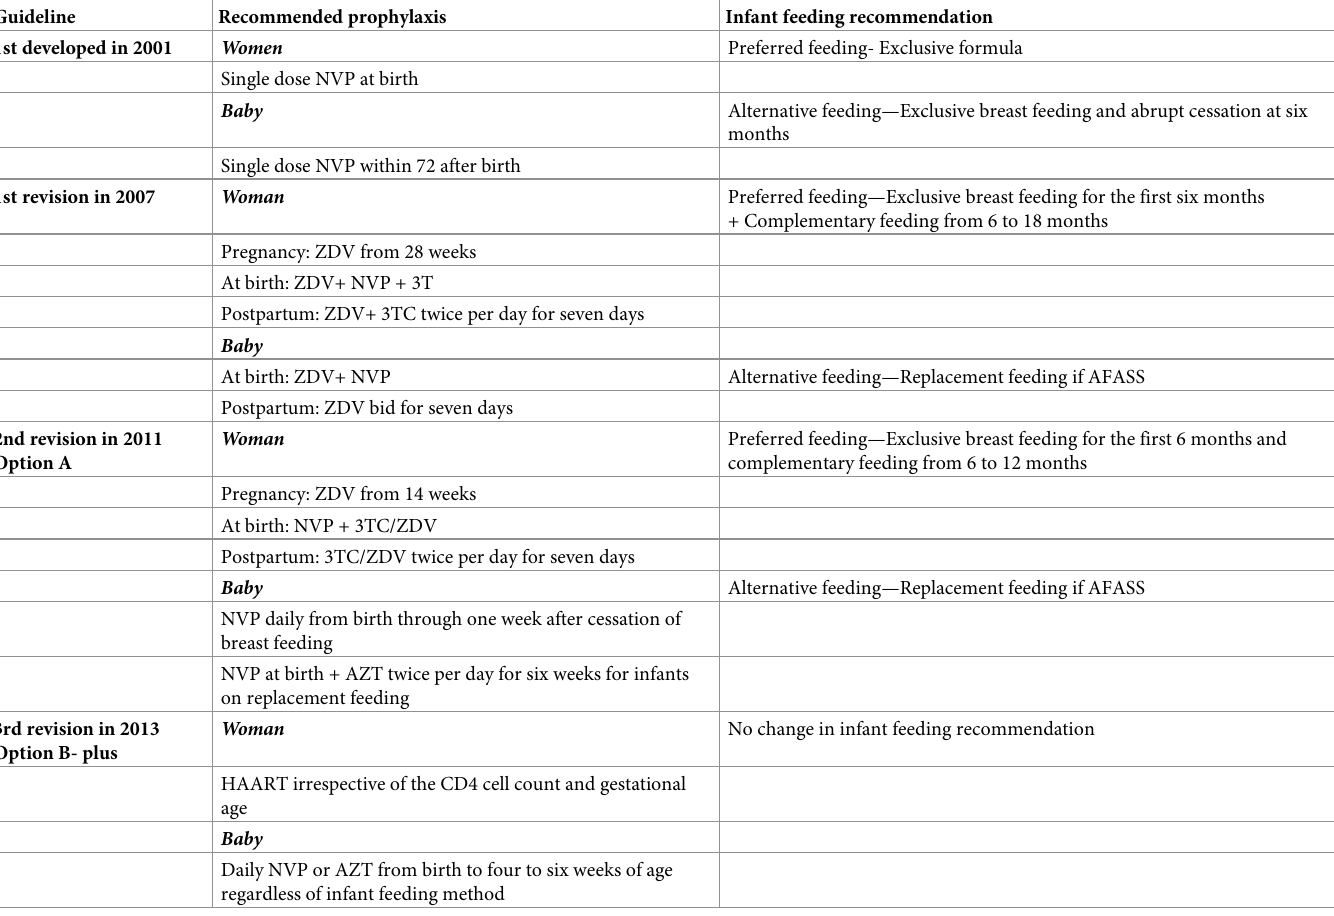
Table 1. Chronology of the national PMTCT guideline revisions and recommended interventions in Ethiopia.